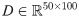
Gap between final (T = 200) ESNR of K-SVD and R-SVD obtained with all parameter combinations L = 2000, 4000, 6000, 8000, 10000 and SNR = 0, 10, 20, 30, 40, 50, 60, ∞ (no noise).Results are averages over 100 trials; points are interpolated with coloured piece-wise planar surface for sake of readability. Left: D∈R50×100 with sparsity k = 5. Right: D∈R100×200 with sparsity k = 10.